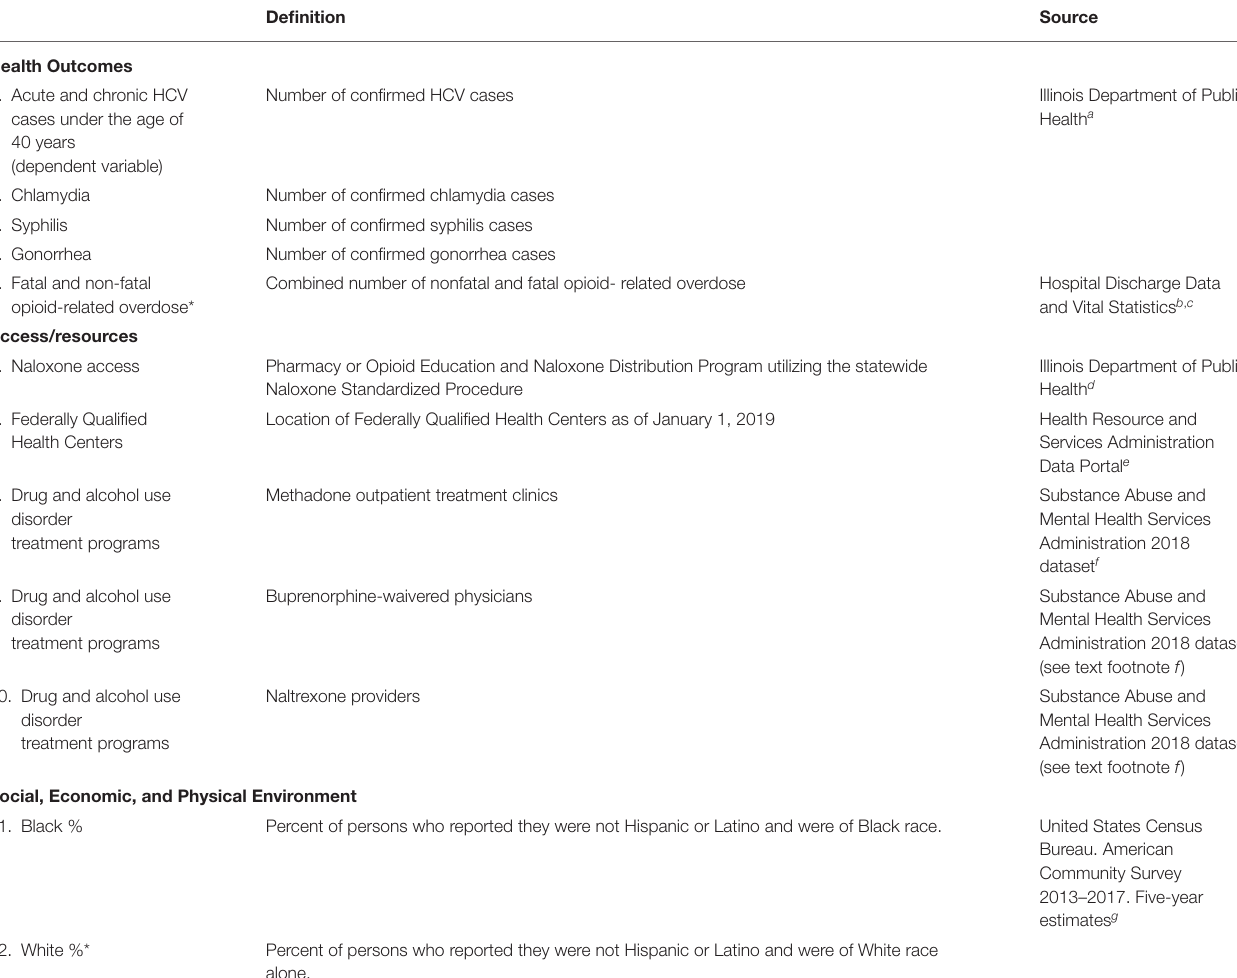
TABLE 1 | Dependent variable and indicators originally identified to be used in regression model at the ZIP code level, Illinois, 2017–2018. Definition Source Health